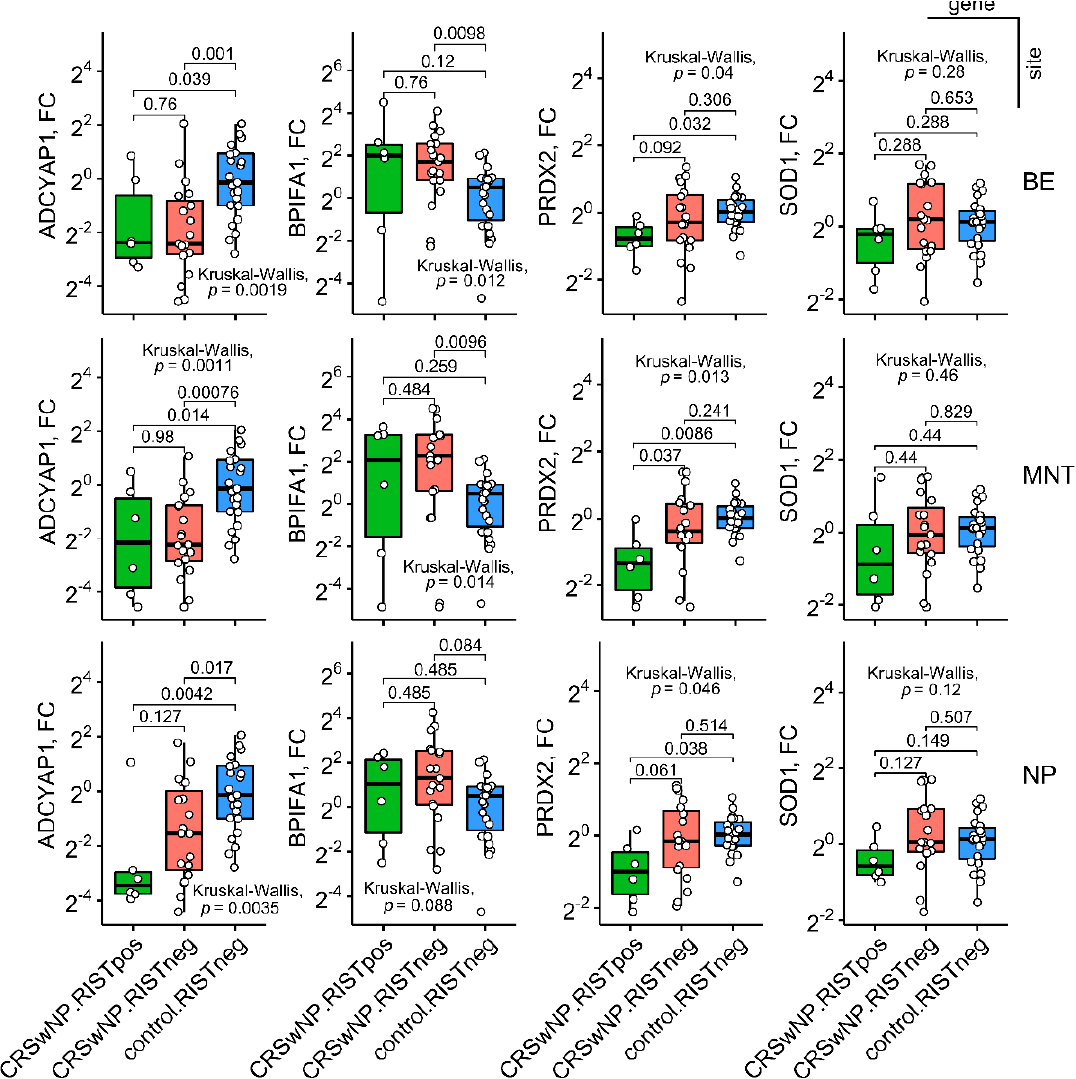
Figure 4. Boxplots showing gene expression (fold change (FC), log2-scale) in annotated groups, according to serum radioimmuno assay (RIST) of immunoglobulin E positivity (two-tailed Kruskal– Wallis test, post hoc Conover’s test, false discovery rate correction). Horizontal lines represent median with interquartile range. p < 0.05 was considered significant. BE: bulla ethmoidalis, MNT: middle nasal turbinate, NP: nasal polyp. n (CRSwNP.RIST.pos) = 6, n (CRSwNP.RIST.neg) = 19, n (control.RIST.neg) = 23 .